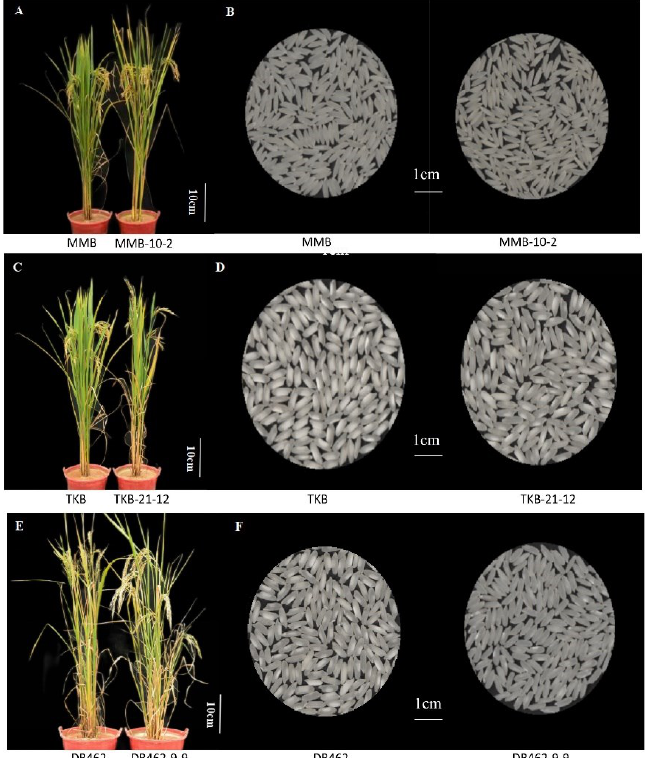
Figure 9. Comparison of plant type and polished rice appearance between mutant lines in the T 2 generation and their respective wild types. ( A , B ): Comparisons between MMB and MMB-10-2; ( C , D ): Comparisons between TKB and TKB-21-12; ( E , F ): Comparisons between DR462 and DR462- 9-9.